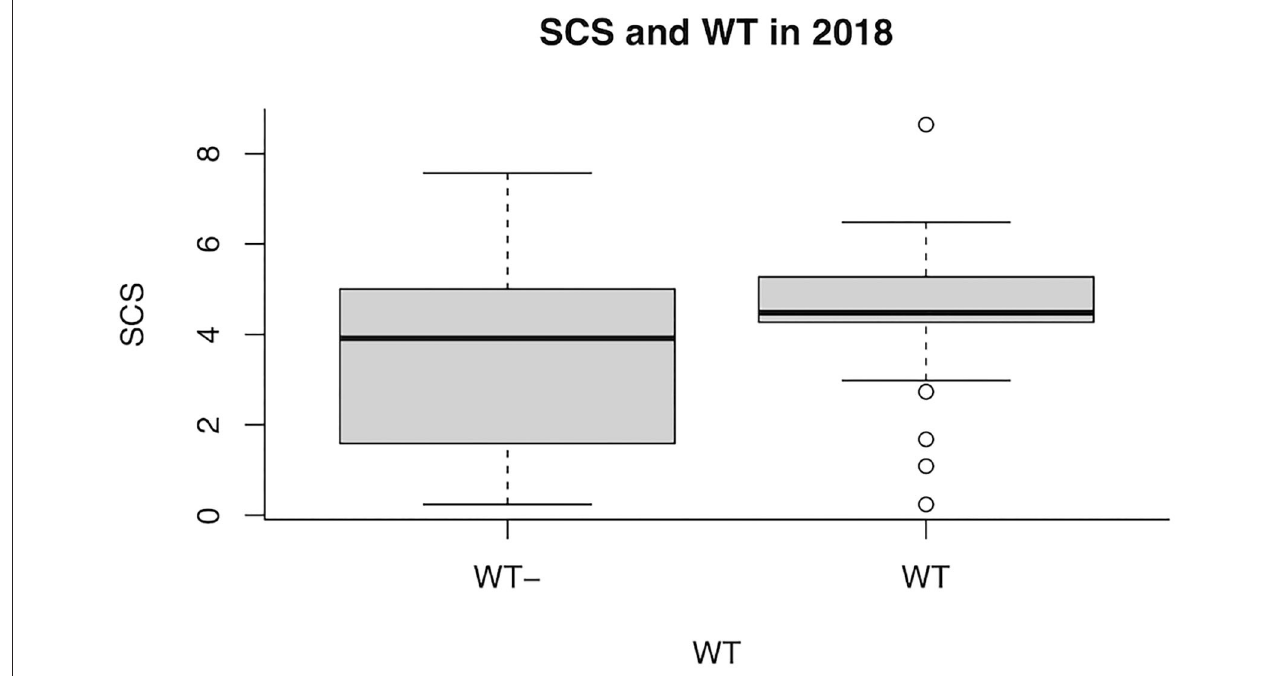
FIGURE 1 | Box plot of somatic cell score (SCS) in goats with (WT + ) and without (WT–) weeping teats in herd A in 2018.